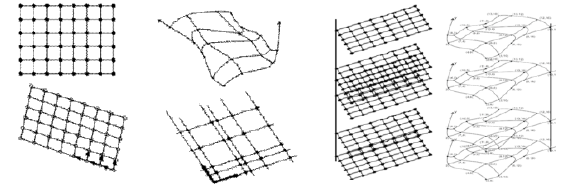
Figure 1. Sample coverage grid types